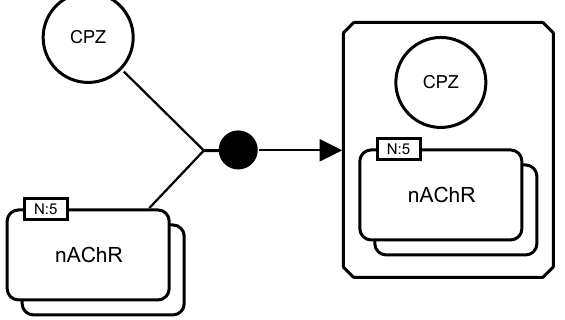
Figure 2.33: The association of a pentameric macromolecule with a simple chemical in an unnamed complex.